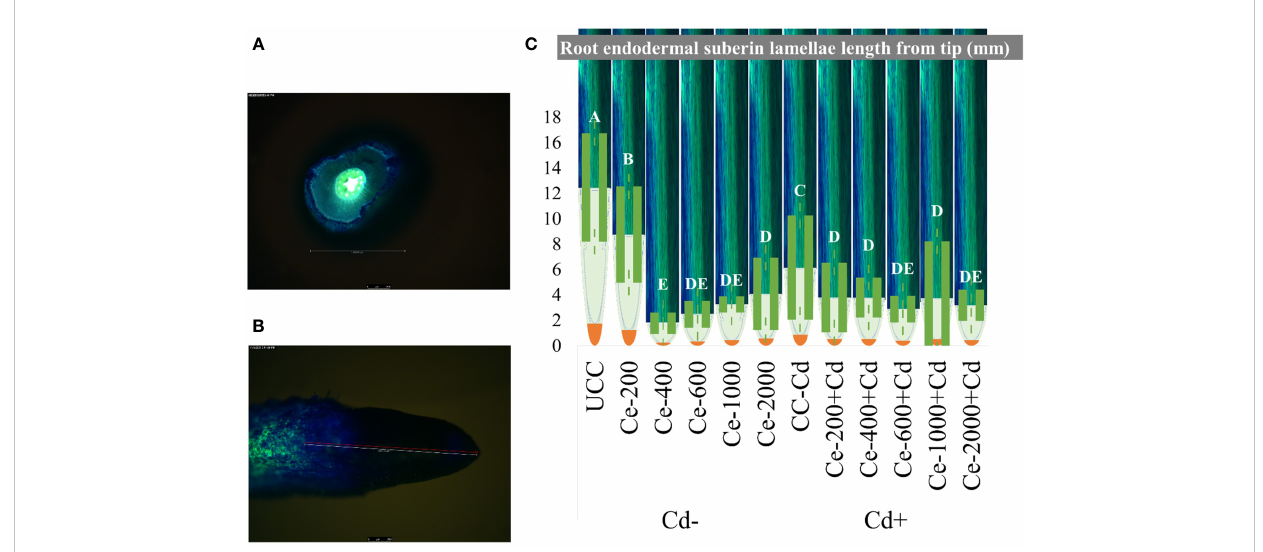
FIGURE 7 Root endodermal Suberin Lamellae (barrier formation) length on maize seedling roots under CeO2-NPs applied at 200, 400, 600, 1000 and 2000 mg kg -1 dry sand alone (Cd-) and in combination with 0.5 mg kg -1 Cd (Cd+). (A) Cross section of root with full barrier formation, (B) The gradual development of barriers from tip (green color development), (C) Mean root barrier distance from root tip. The error bars given on mean are of standard deviation